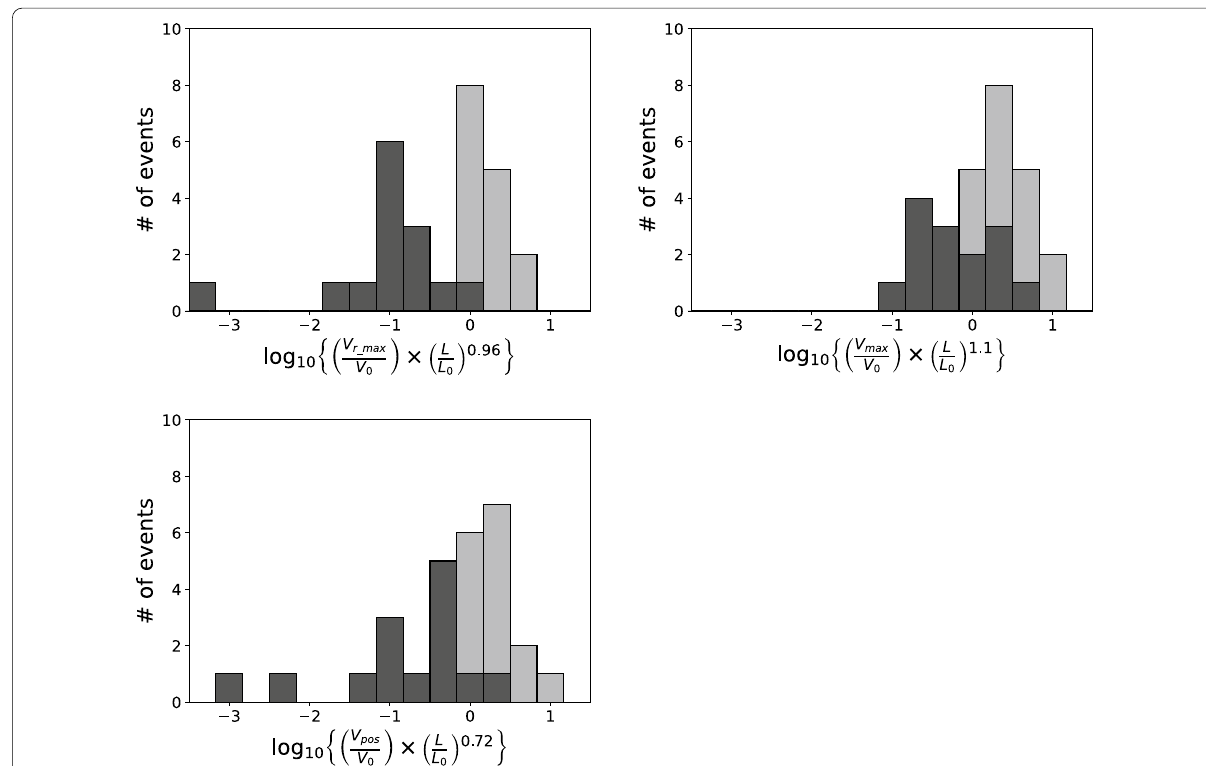
Fig. 2 Histograms of the LHS of Eqs. (1)–(3) on a common logarithmic scale. The dark and light grey bars correspond to the events without and with CMEs, respectively. The bars are stacked. The size of a bin is